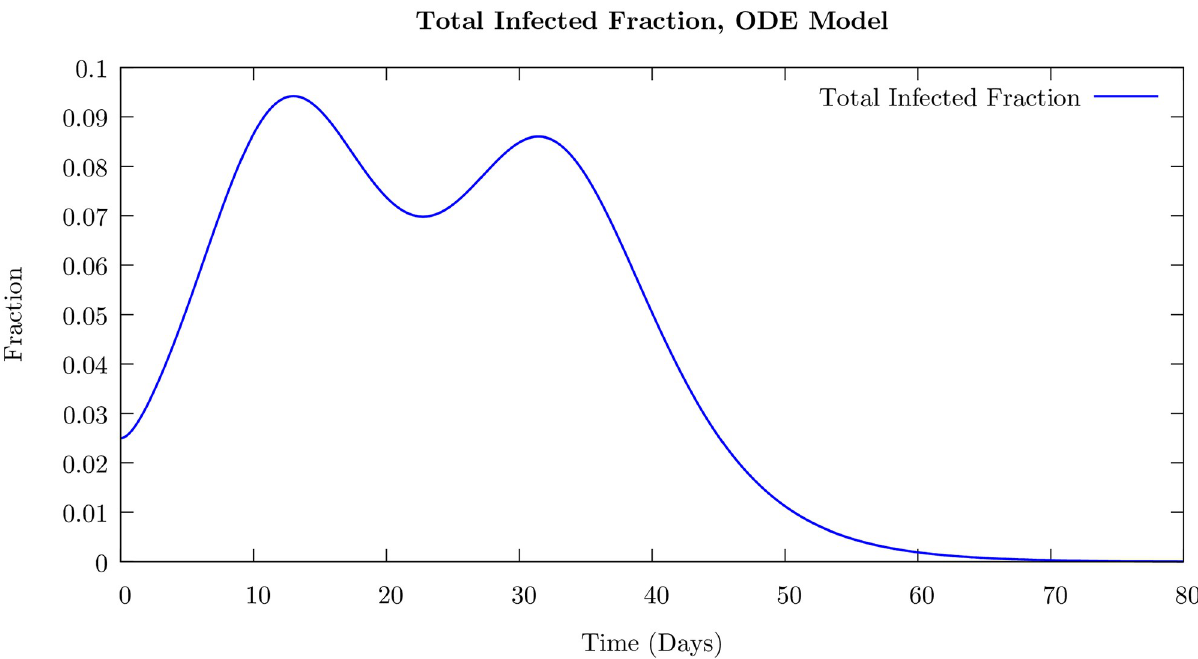
Fig 2. Total infected (sum of exposed and infectious agents) number as a function of time for two-cohort SEIR model defined in Eq 3. Here, β 11 = β 22 = 2, and β 12 = β 21 = 0.01, and the recovery rate ν is 0.10. The separation in infection timescale between intra-cohort spread and inter-cohort spread leads to two distinct peaks in the infected number. This peak separation decreases if the infection rates are made closer in value, as well if the recovery rate is made too rapid. This behavior is compared with the mean behavior of the infected number in the ABM later in the text.